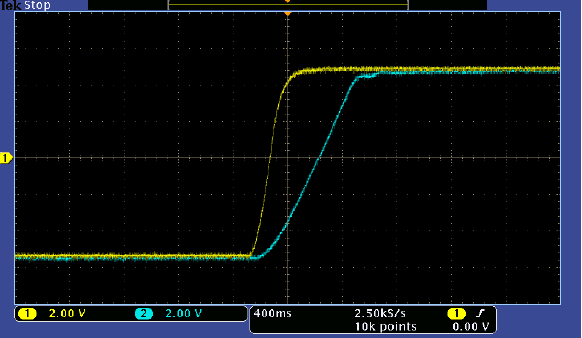
Figure 13. Removal of ringing by velocity feedback, gain=15.